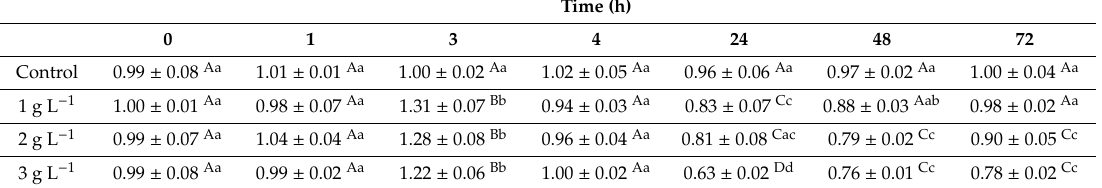
Table 1. Time course of changes in phaeopigments vs. chlorophyll a ratio ([Phaeo] / [Chl- a ]) in control and in sodium bicarbonate enriched cultures. Values are means (n = 3) ± standard deviation. The superscript letters indicate the statistical significance: identical letters identify means that are not significantly di ff erent; di ff erent letters identify statistically di ff erent means ( p ≤ 0.001). Upper case letters indicate the comparison between the experimental conditions (control, 1, 2, and 3 g L − 1